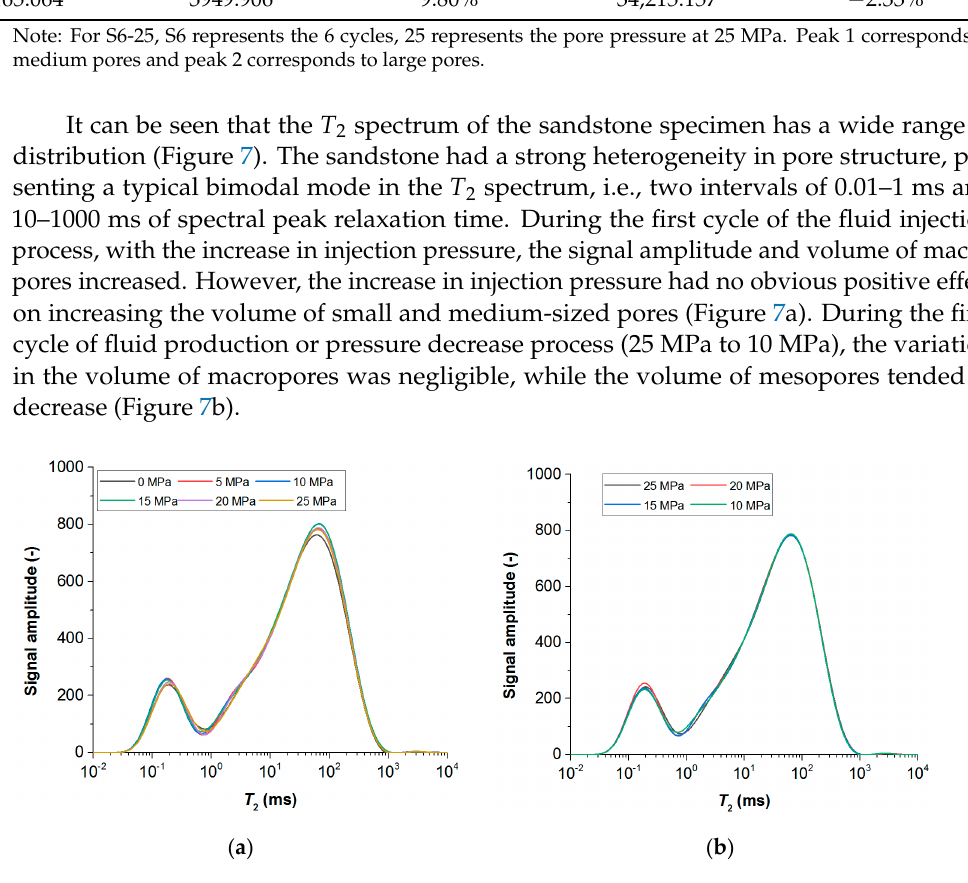
Figure 7. Variation curve of transverse relaxation time ( T 2 ) during the first cycle of injection and production in sandstone (( a )—Pore pressure increase process; ( b )—Pore pressure decrease